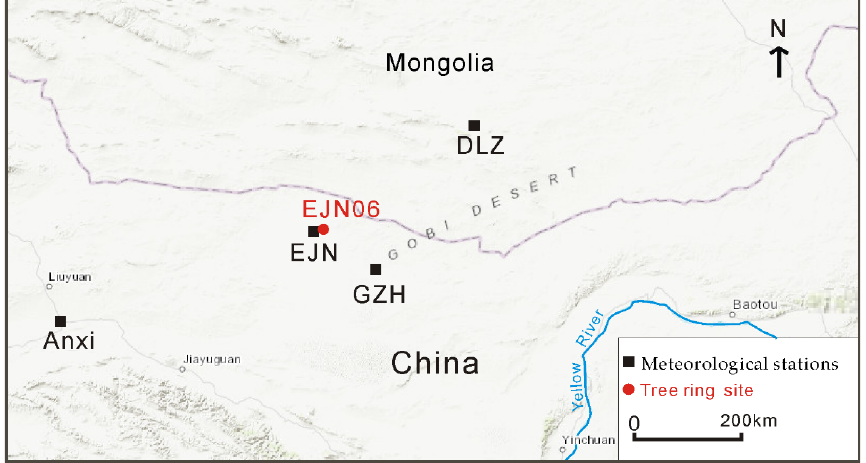
Figure 1. Map showing the locations of the sampling site and the meteorological stations. Tree-ring sampling site (EJN06) is shown as red circle. Meteorological stations (EJN, GZH, DLZ and Anxi) are shown as solid black Squares.